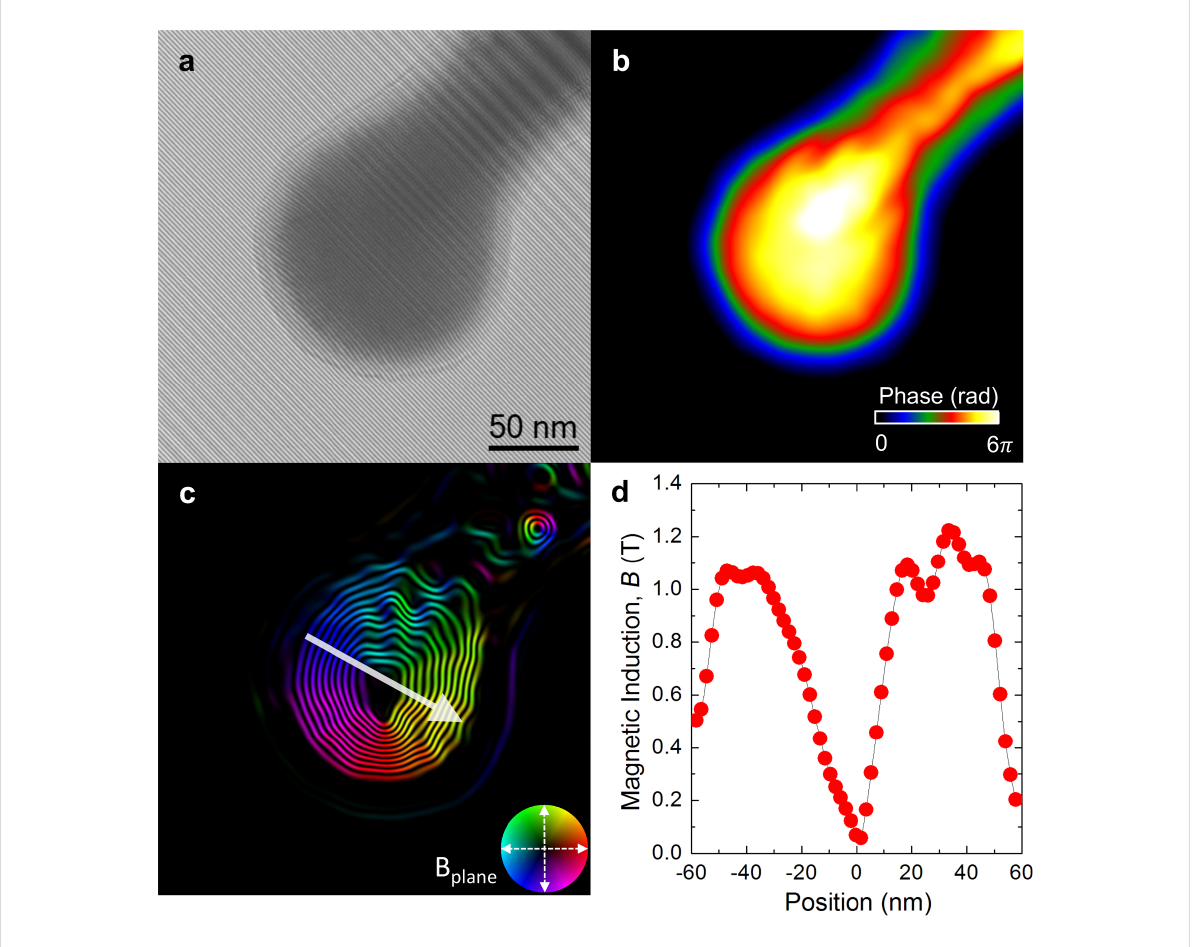
Figure 5: Electron holography of one cobalt nanosphere with a diameter of 110 nm. a) Electron hologram of the object. b) Electrostatic phase image, φ E . c) Colored representation of the in-plane magnetic induction flux lines, represented as cos(12· φ M ). The inset represents the color scale of the magnetic induction orientation in arbitrary units, where the position of a color relative to the center of the circle corresponds to the orientation of the magnetic induction. d) Profile of the in-plane component of the magnetic induction vector as measured along the white arrow c), where the position reference is taken at the minimum of the magnetic